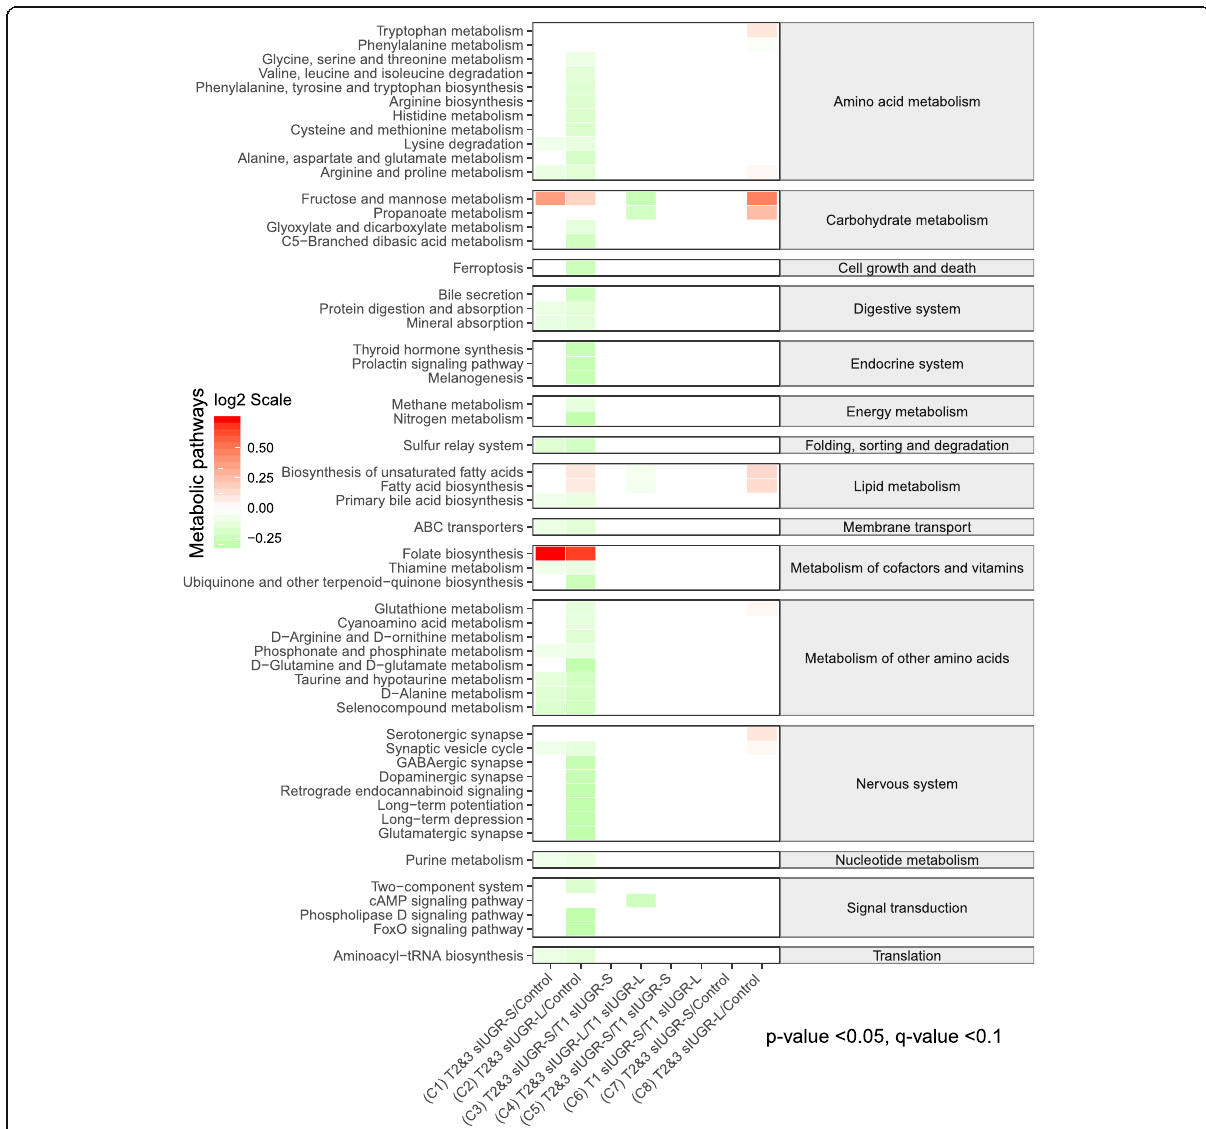
Fig. 7 Comparing metabolic pathways in the hair metabolome associated with T1 sIUGR, T2&3 sIUGR, and control MCDA twins. The predicted metabolic activity was illustrated using log 2 fold changes. Red color blocks represent upregulated metabolic activity in dividend groups compared to the divisor groups, whereas green color blocks represent downregulated metabolic activity in dividend groups compared to the divisor groups. Only the metabolic pathways with a significant p-value (logistic regression: p < 0.05) and q-value (FDR: q < 0.05) are plotted. List